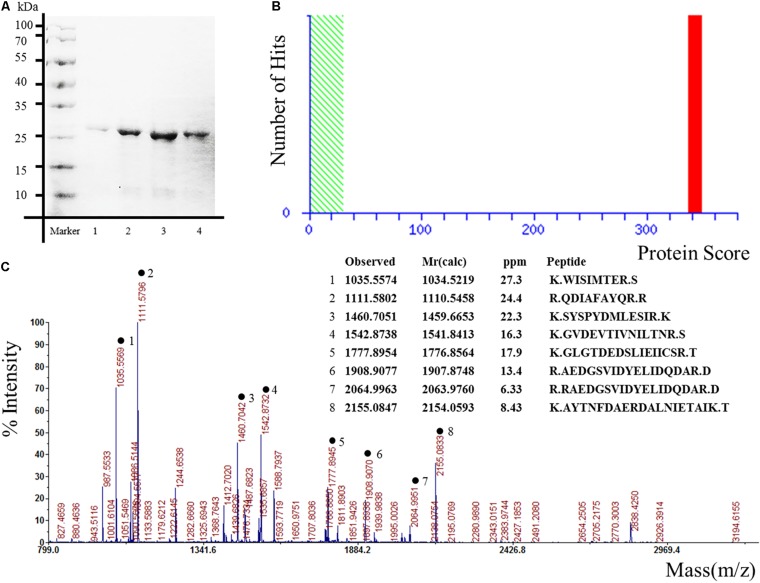
Expression, purification, and identification of recombinant proteins for protein microarrays. The recombinant proteins were expressed from the bacterial clones and purified, in parallel, under denaturing conditions. Annexin A2 was represented. (A) Result of scanning on SDS-PAGE gels. Lane 1–4 represented different elution times. (B) Ions score is –10∗Log (P), where P is the probability that the observed match is a random event. Individual ions scores > 29 indicate identity or extensive homology (P < 0.05). Protein scores are derived from ions scores as a non-probabilistic basis for ranking protein hits. (C) Proteins mass spectrometry analysis.